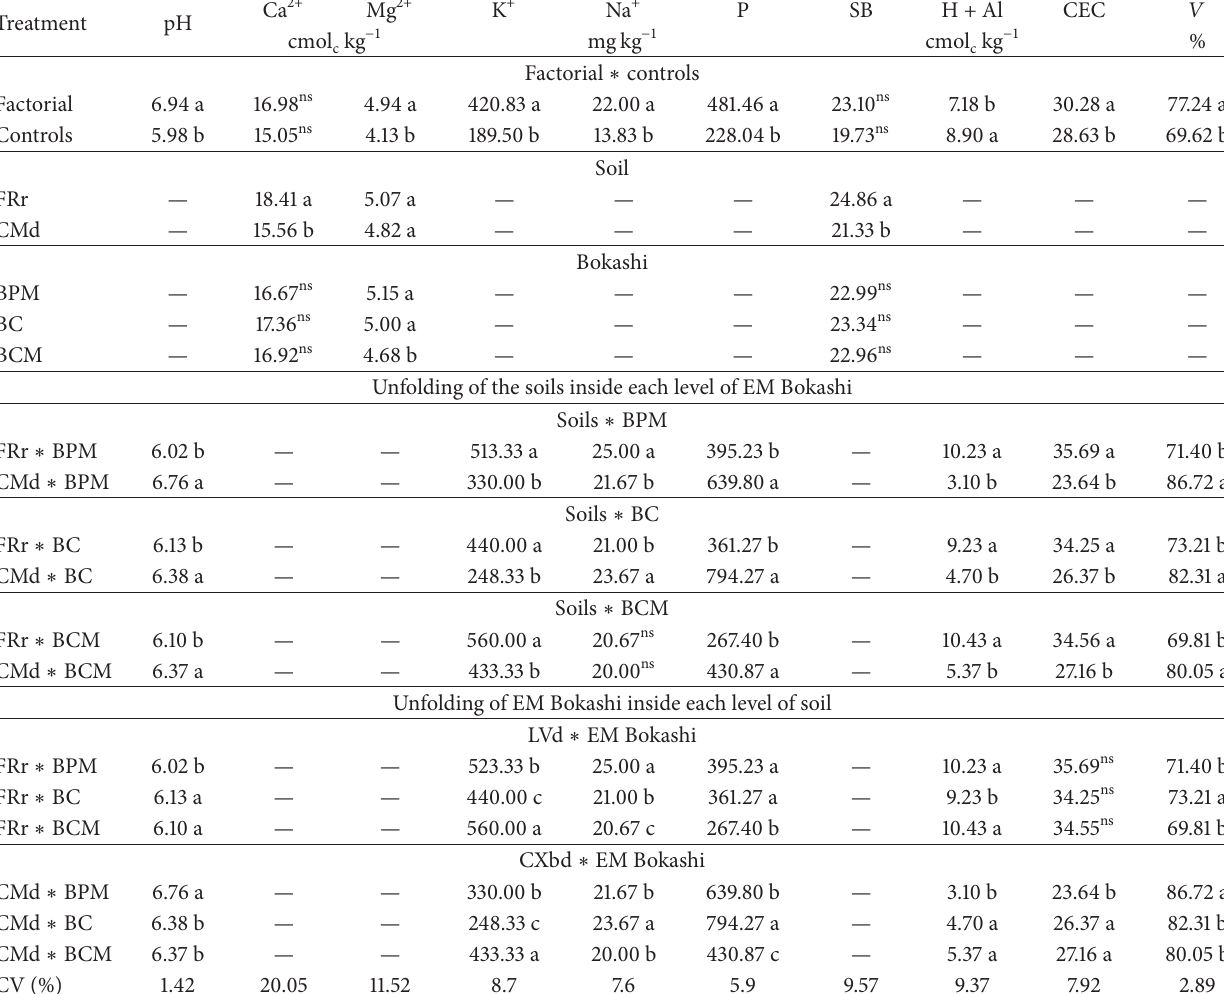
Table 3: Means of the fertility attributes evaluated in a FRr and a CMd fertilized with EM Bokashi and cultivated with tomato. Treatment